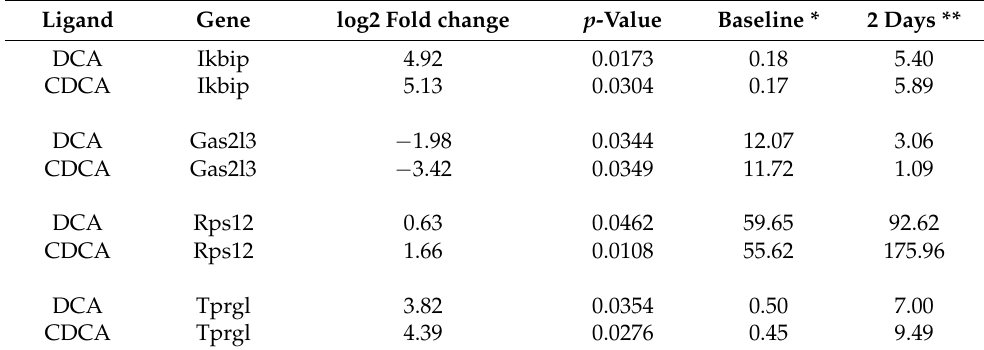
Table 2. Genes whose changes in expression were similar in DCA and CDCA treated NCE34